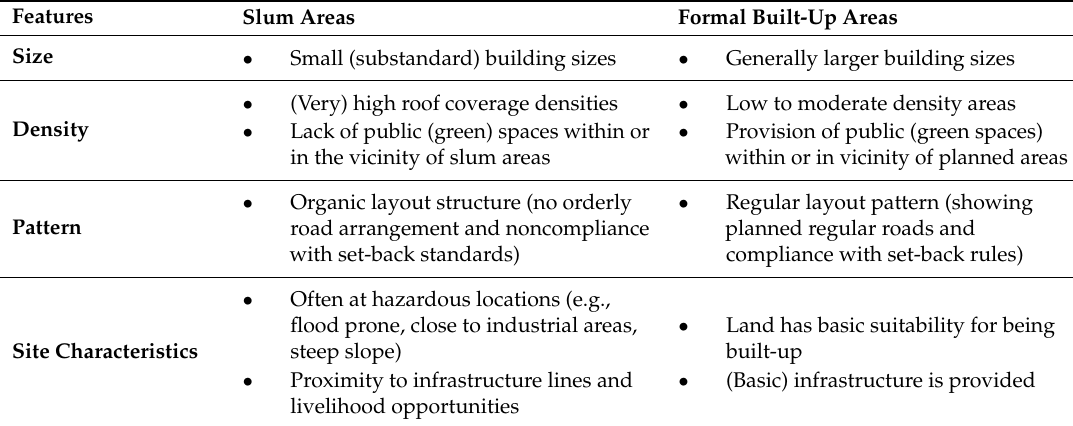
Table 1. Morphological features typical for slum areas (adapted from